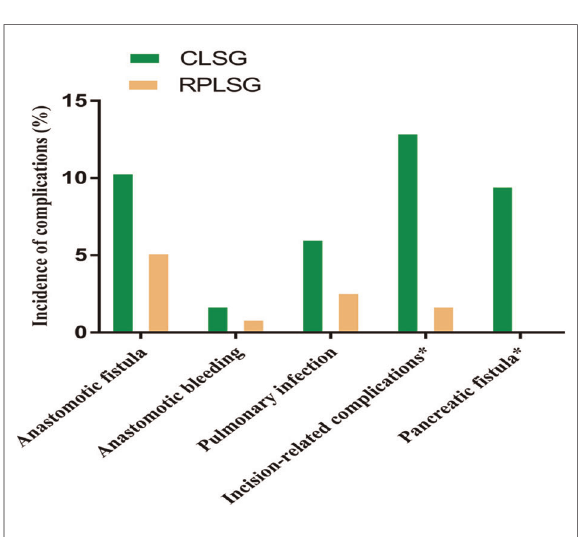
FIGURE 4 Effect of different surgical methods on the incidence of postoperative complications.